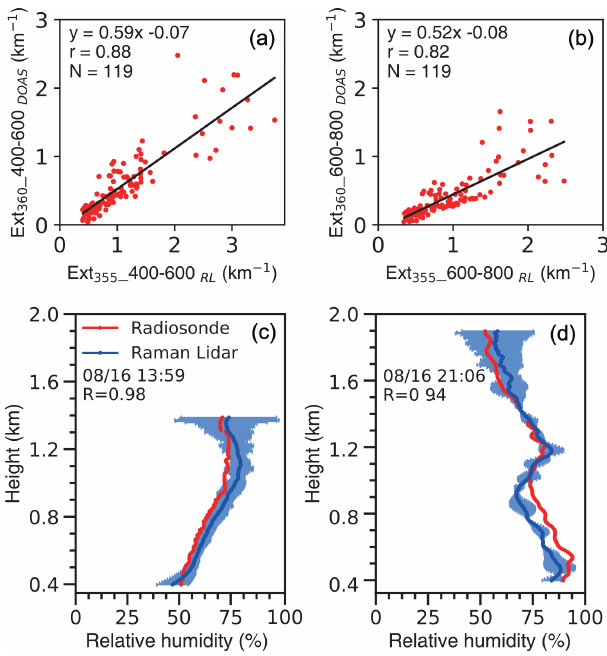
Figure 1. Data comparison of RL and MAX-DOAS. Correlations between EXT from MAX-DOAS and RL for layers of (a) 400– 600m and (b) 600–800m. RH comparison between radiosonde and RL at (c) noon and (d) night. The envelopes in (c) and (d) represent the errors at each altitude. The error is calculated from the law of error propagation, which primarily depends on the signal-to-noise ratio (Heese et al., 2010) of the input signal given in Table